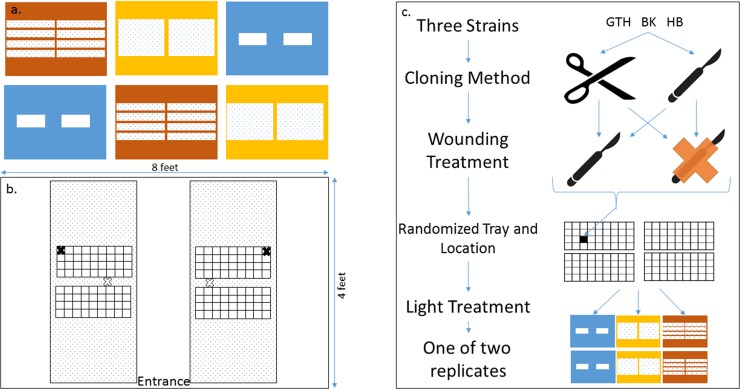
Schematic of experiments to quantify the effect of lighting, stem scarring, and tool used on the rooting probability and timing of Cannabis clones.A) Blue, red, and yellow rectangles represent the plasma, T5, and T8 tents respectively. White squares within each tent represent the approximate size and placement of lamp fixtures. B) Tray layout within each experimental tent; black X—air temperature/humidity probe, white X- seedling heating mat thermostat probe C) Experimental procedure. Cuttings were taken using either secateurs or a scalpel and were randomly allocated to a tray position in a lighting treatments replicate.